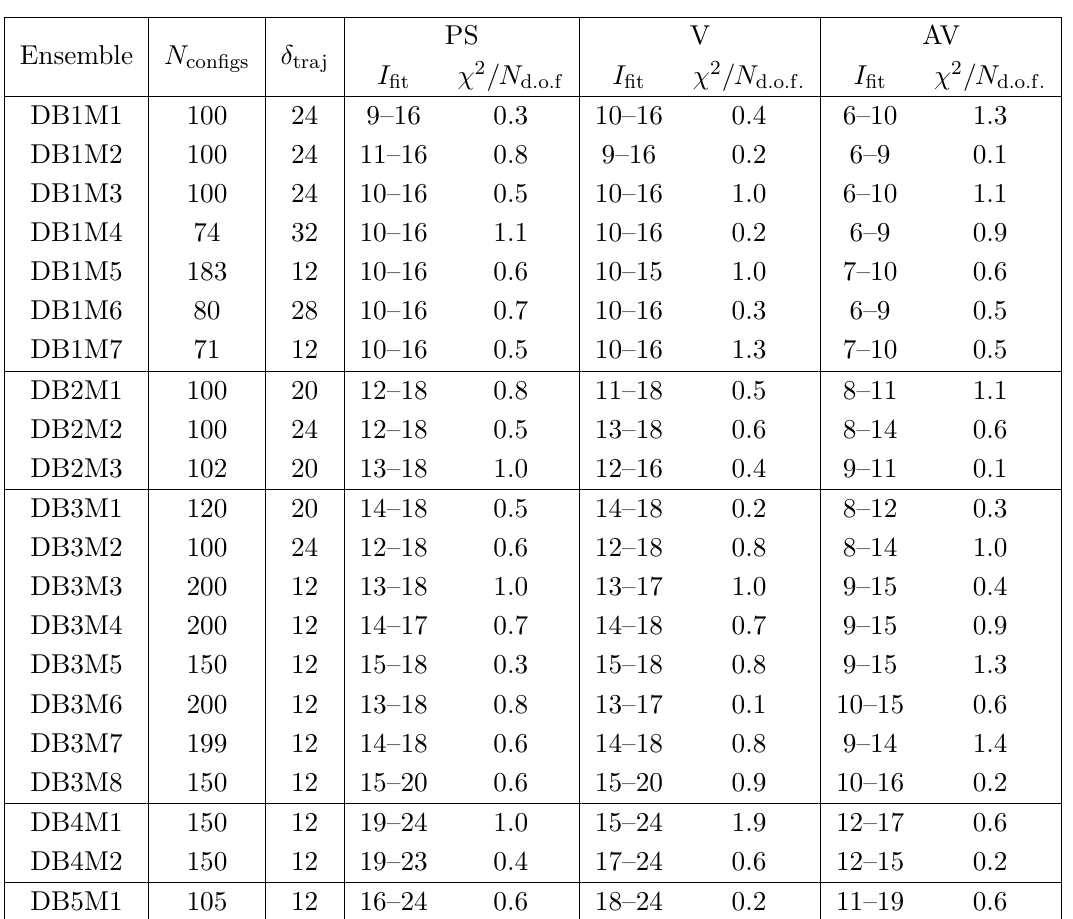
Table 12. Fitting intervals of the Euclidean time I (cid:12)t = [ t i ; t f ] used in the single-exponential (cid:12)t of the measured correlators for PS, V and AV mesons. The number of con(cid:12)gurations and the separation between the adjacent con(cid:12)gurations are denoted by N con(cid:12)gs and (cid:14) traj , respectively. We carry out a correlated (cid:12)t using standard (cid:31) 2 minimisation. We show the resulting values of (cid:31) 2 =N d : o : f : , as a way to assess the quality of the (cid:12)t